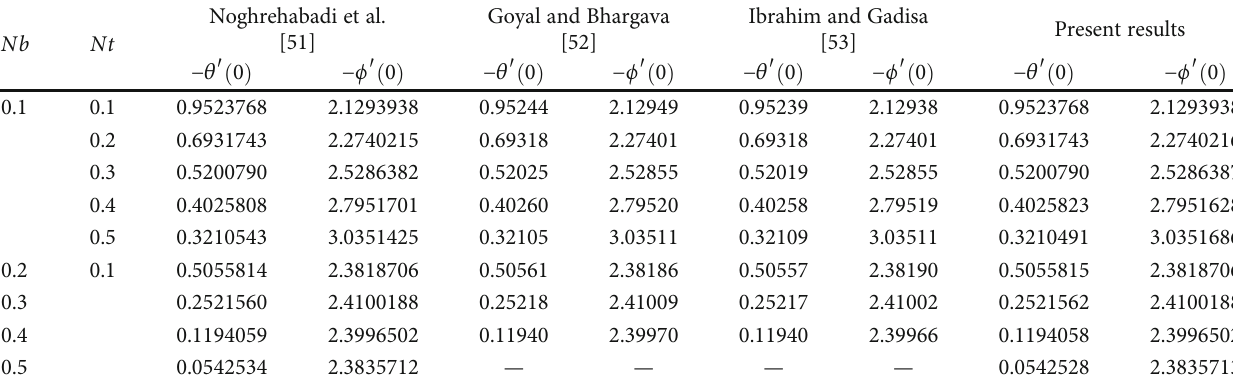
Table 1: Comparison of results for the Nusselt number − θ ′ ð 0 Þ and Sherwood number − ϕ ′ ð 0 Þ for various values of Nb and Nt when Le =